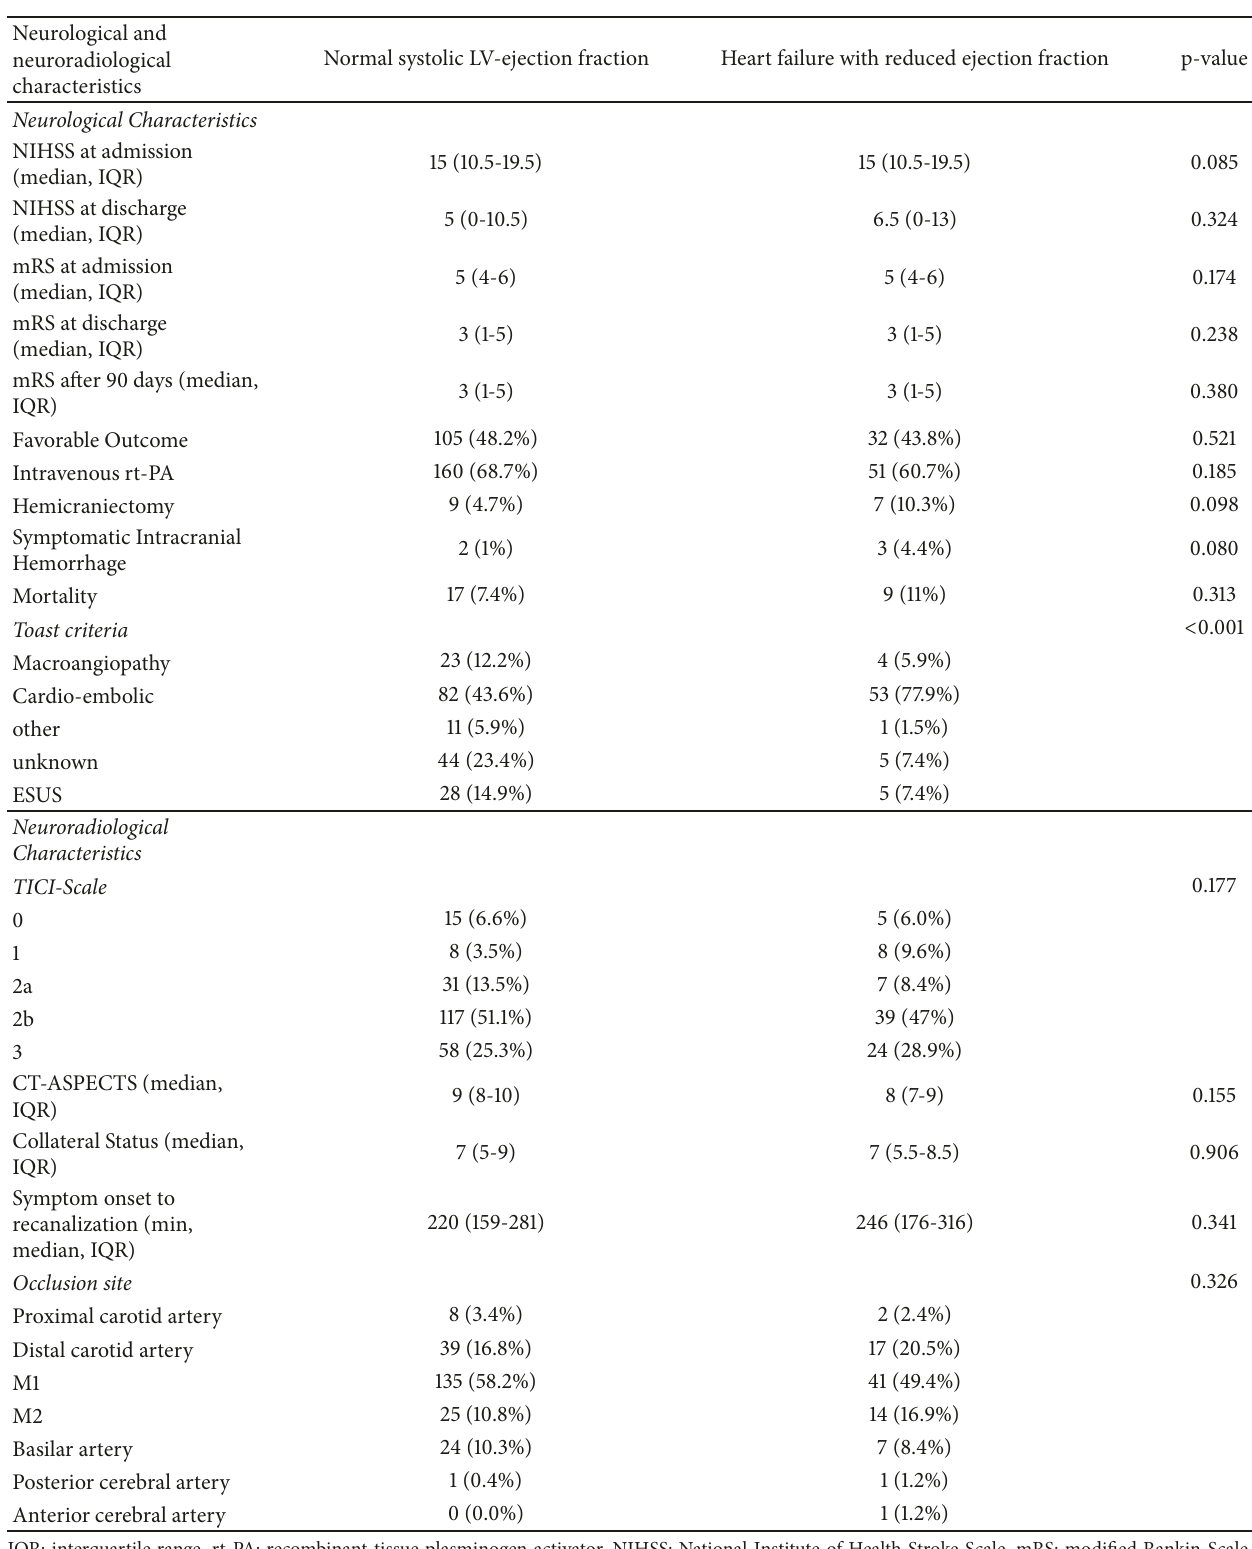
Table 3: Neurological characteristics of patients with and without heart